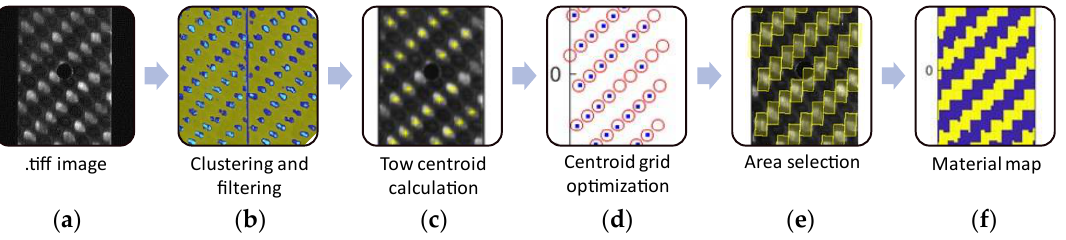
Figure 3. Stages in the process of building the specimen material map: ( a ) raw .tiff image captured with DIC cameras, ( b ) after K-means clustering and filtering, ( c ) centroid of the tows calculated from the clusters overlaid on the initial image, ( d ) fitting through optimization of a geometric grid (red circles) to the centroids (blue dots), ( e ) selection of the vertical tow area, ( f ) material orientation map used to prepare the FEM model via a Python script.